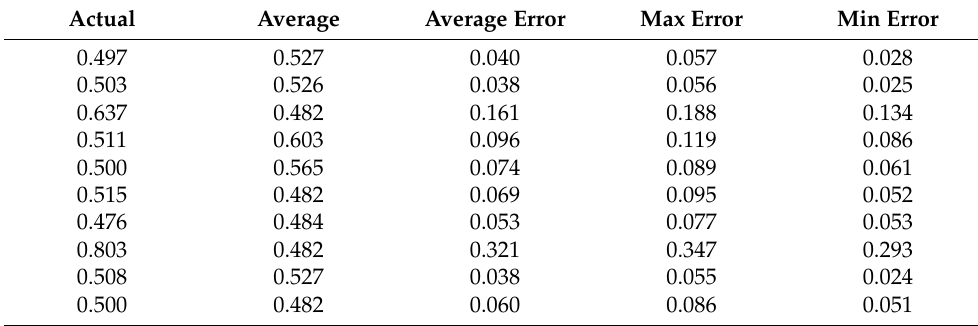
Table A82. Set 2, trials 1–10 data (average actual PR values).